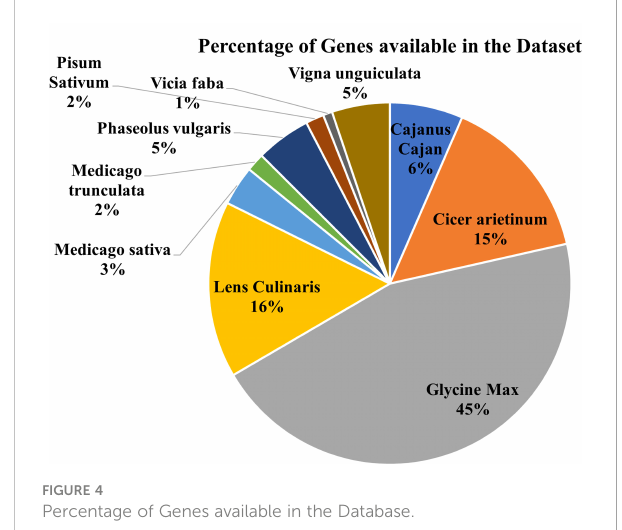
FIGURE 4 Percentage of Genes available in the Database.